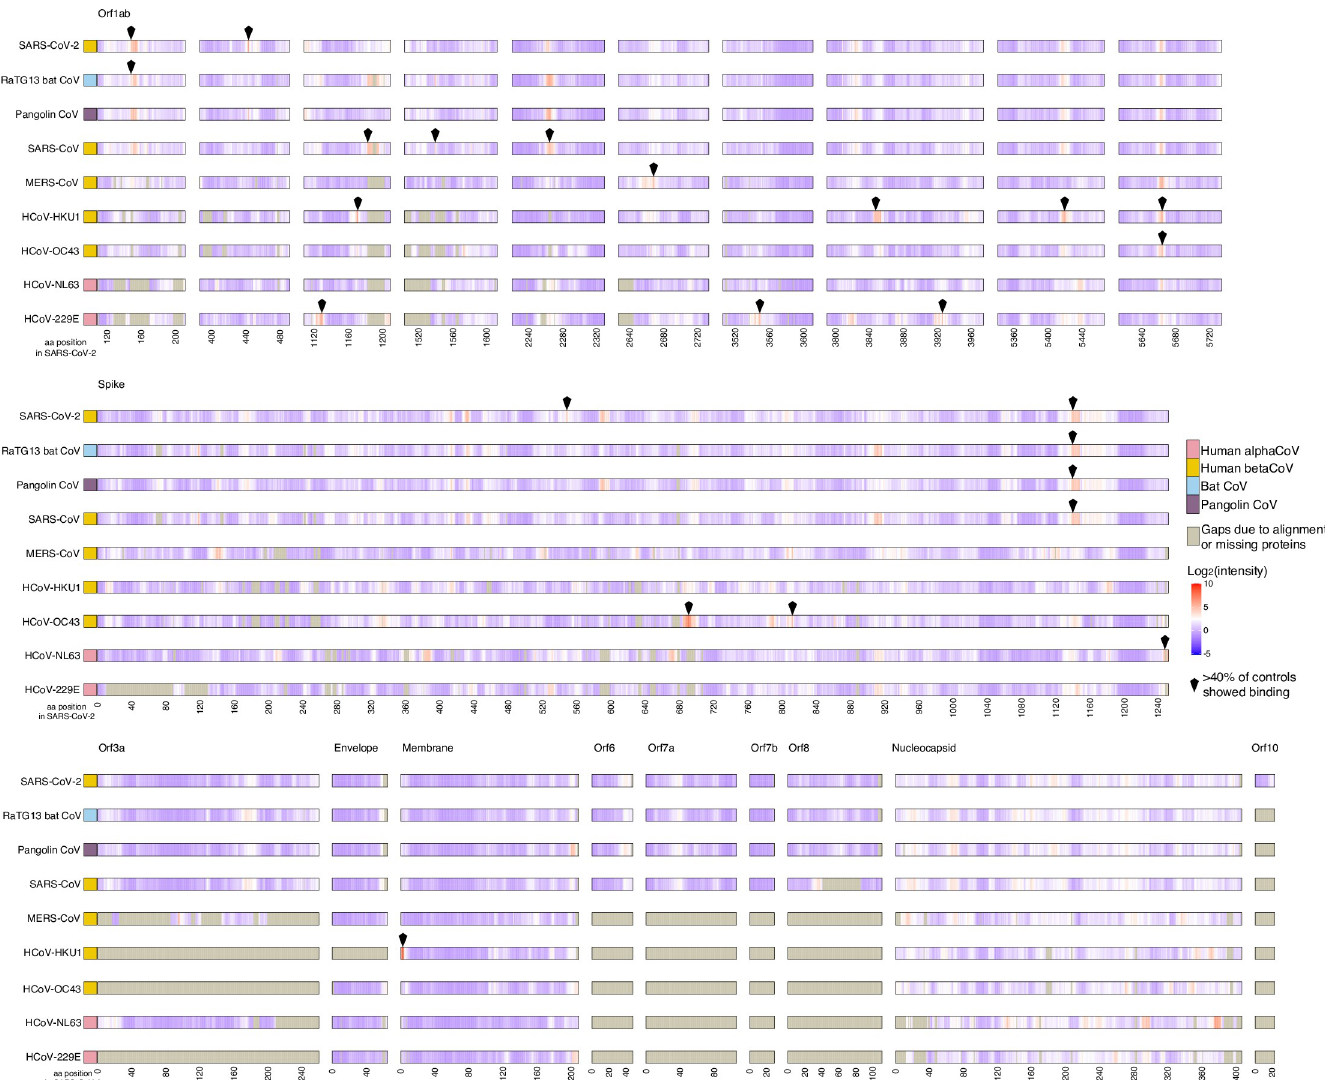
Fig 2. Control sera show reactivity to CCCoVs and to SARS-CoV, MERS-CoV, and SARS-CoV-2. Sera from 20 controls collected before 2019 were assayed for IgG binding to the full proteomes of 9 CoVs on a peptide microarray. Viral proteins are shown aligned to the SARS-CoV-2 proteome with each virus having an individual panel; SARS-CoV-2 aa position is represented on the x-axis. Binding was measured as reactivity that was > 3.00 standard deviations above the mean for the log 2 - quantile normalized array data. Peptides for which > 40% of the controls showed binding are indicated by a black diamond. The data used in this analysis can be accessed online at: https://github.com/Ong-Research/UW_Adult_Covid-19. aa, amino acid; CCCoVs, “common cold” CoVs; CoV, coronavirus; IgG, immunoglobulin G; MERS-CoV, Middle Eastern respiratory syndrome coronavirus; SARS-CoV, severe acute respiratory syndrome coronavirus; SARS-CoV-2, severe acute respiratory syndrome coronavirus